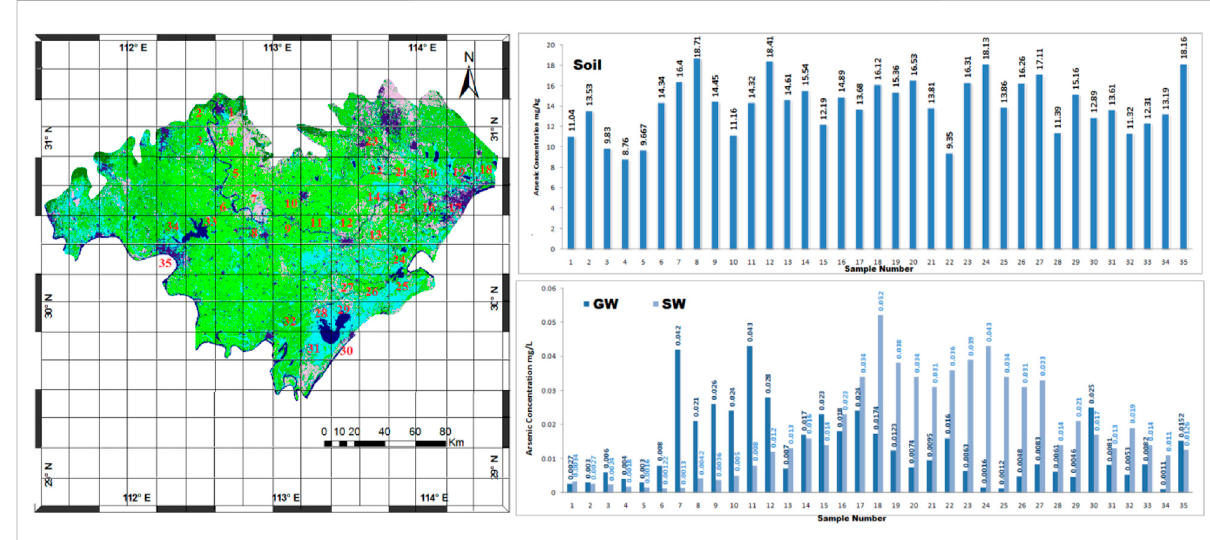
FIGURE 8 Spatial variations in arsenic concentrations in the GW, SW, and soil in Jianghan Plain.